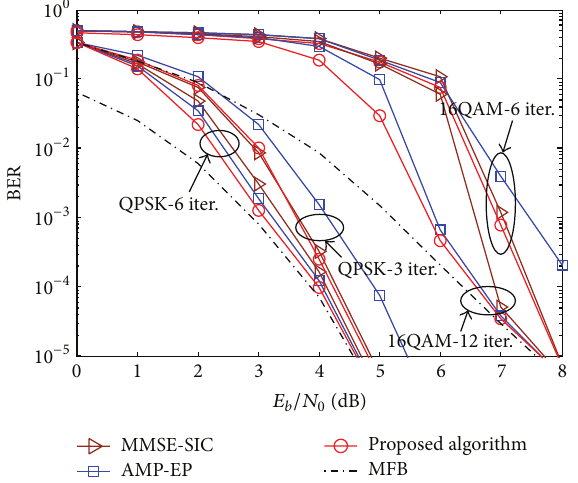
Figure 8: BER performance for different detection algorithms in a 16 × 16 MIMO system, with QPSK and 16QAM modulation, 16-tap Rayleigh channel with equal tap power.